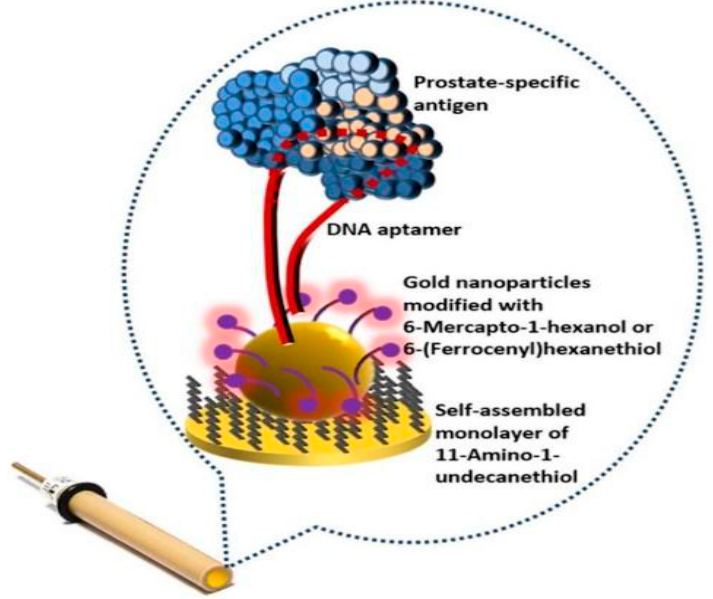
Figure 8. Schematic diagram of self-assembled gold nanoparticles for impedimetric recognition and detection of a prostate cancer biomarker. Figure source: [50]. Reproduction of the figure was granted from the publisher; the reference number is 210801-024863.